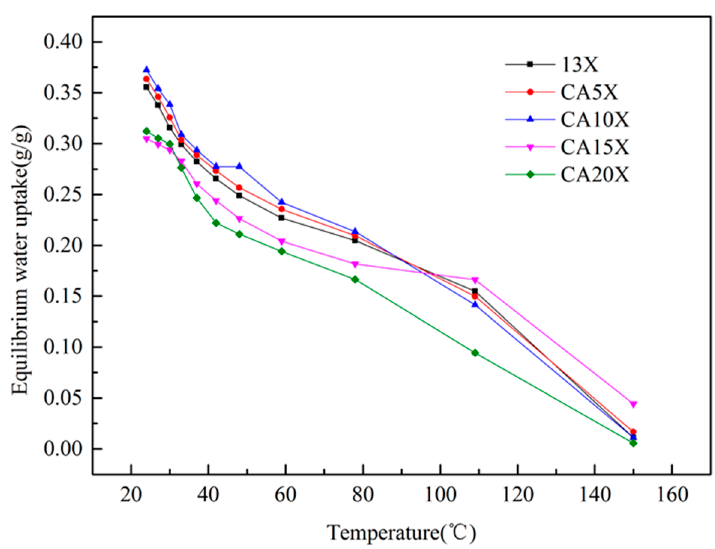
Figure 11. Equilibrium water uptakes changes with temperature.